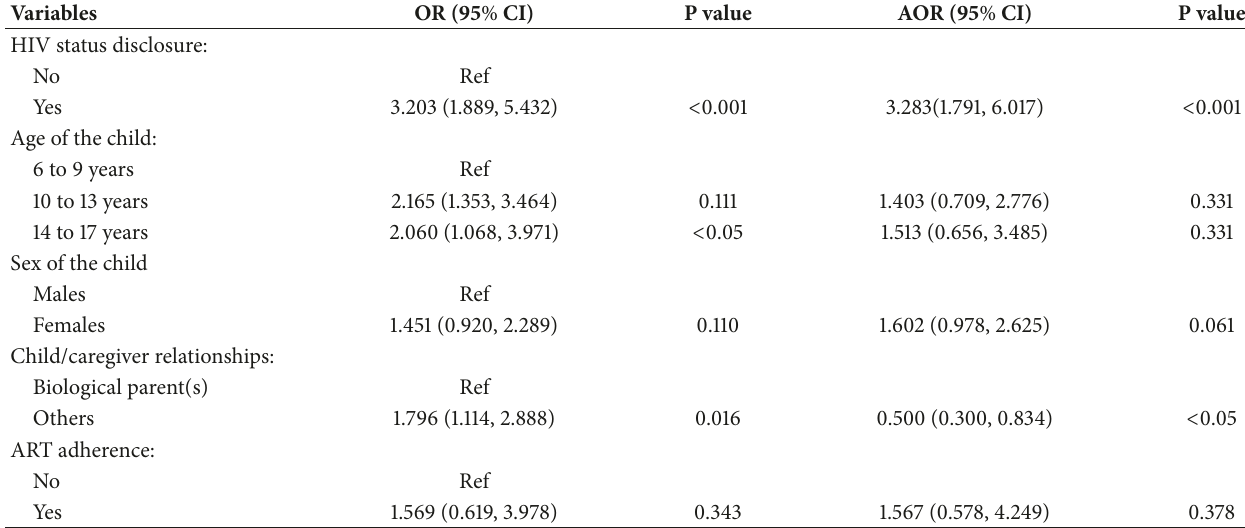
Table 7: Crude and adjusted ratio for the association between HIV status disclosure and quality of life, among children between 6 and 17 years on ART, in Southern Highlands Zone, Tanzania (N =